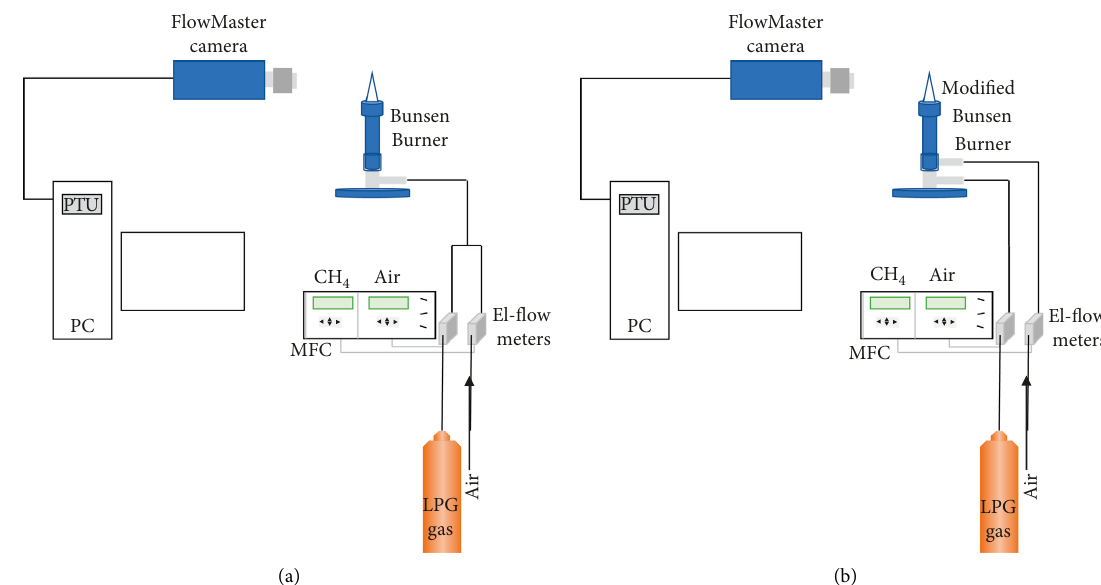
Figure 3: The experimental setup used for laminar burning velocity measurement. MFC, the mass flow controller; PC, personal computer; PTU, programmable timing